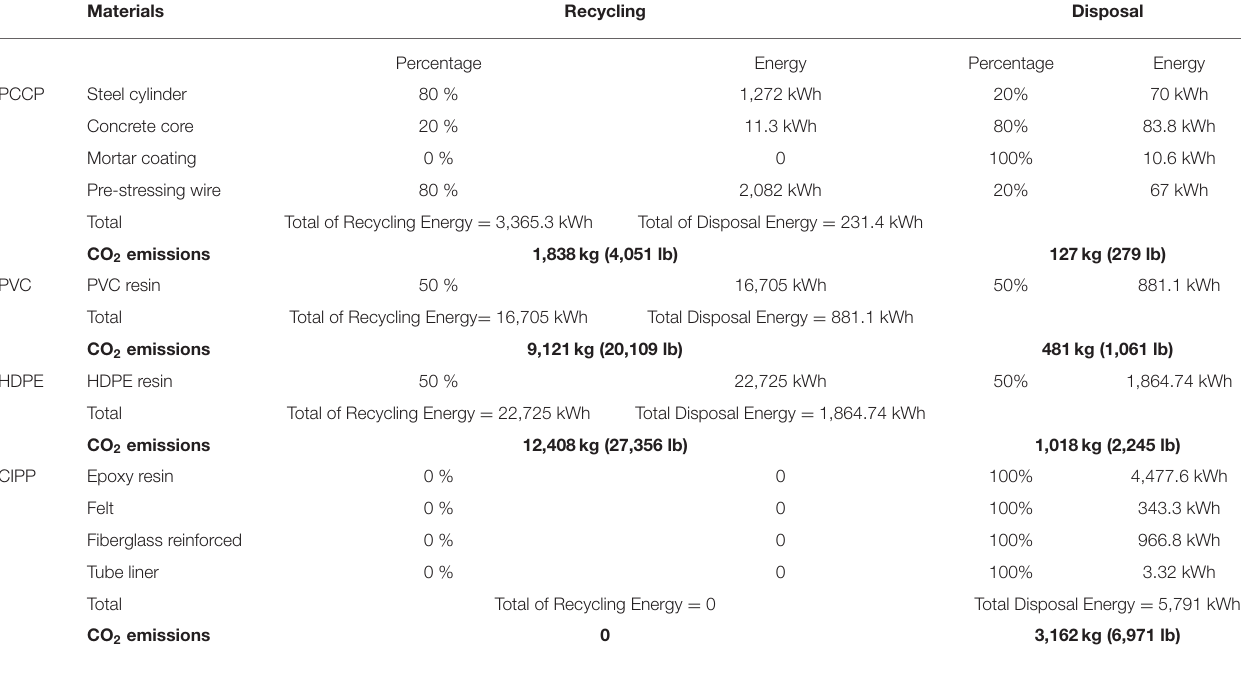
TABLE 8 | Energy consumed for disposal